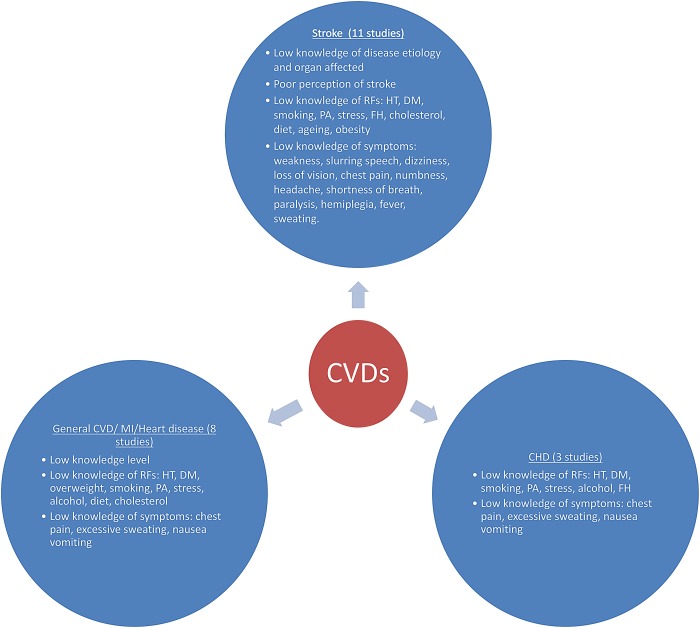
Summary of results.RF, Risk factors; HT, Hypertension; DM, Diabetes Mellitus; PA, Physical activity; FH, Family History; CVD, Cardiovascular disease; MI, Myocardial infarction.